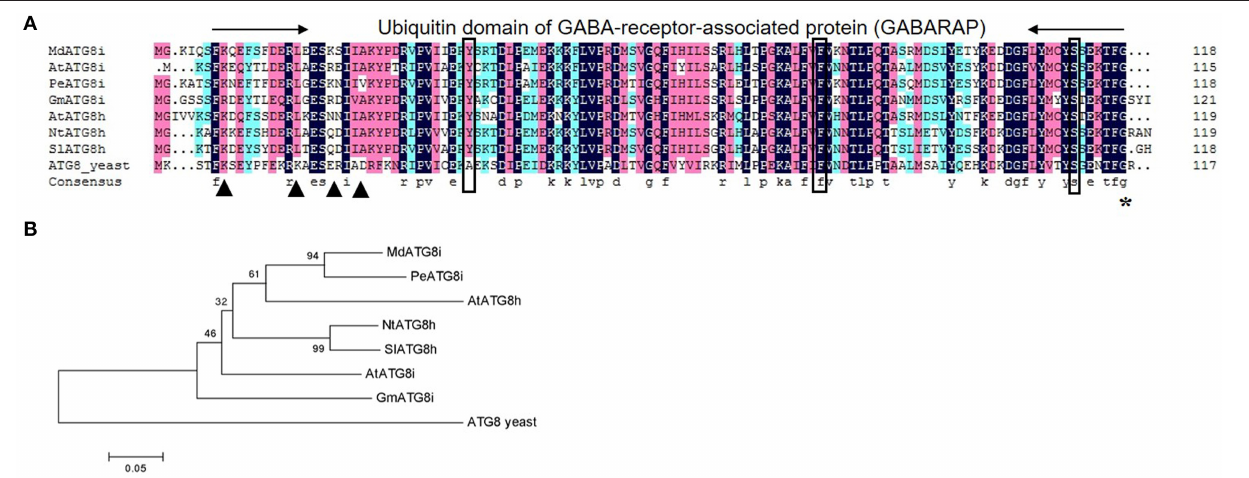
FIGURE 1 | Analysis of amino acid sequence of MdATG8i . (A) Alignment of deduced amino acid sequence from MdATG8i with other ATG8h and ATG8i members. Black triangle, putative tubulin binding sites; Box, ATG7 binding sites; * , Conserved glycine residue; (B) Phylogenetic analysis of ATG8 proteins from Malus domestica ( Md ), Arabidopsis thaliana ( At ), Populus euphratica ( Pe ), Glycine max ( Gm ), Nicotiana tabacum ( Nt ), Solanum lycopersicum ( Sl ), and Saccharomyces cerevisiae (yeast). GenBank Accession Numbers are listed in Table 2